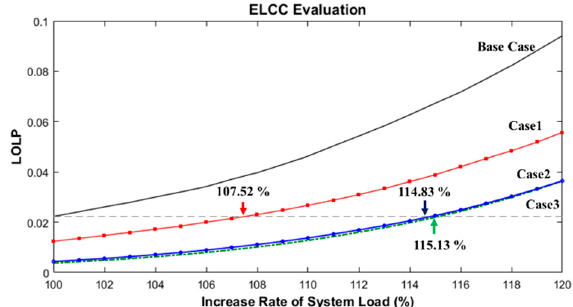
Figure 17. ELCC Evaluation Result. Table 4. Load carrying capability ( ELCC) Evaluation Results. Figure 16. HPP Results under 𝑉 (cid:3045)(cid:3032)(cid:3033) = 60%